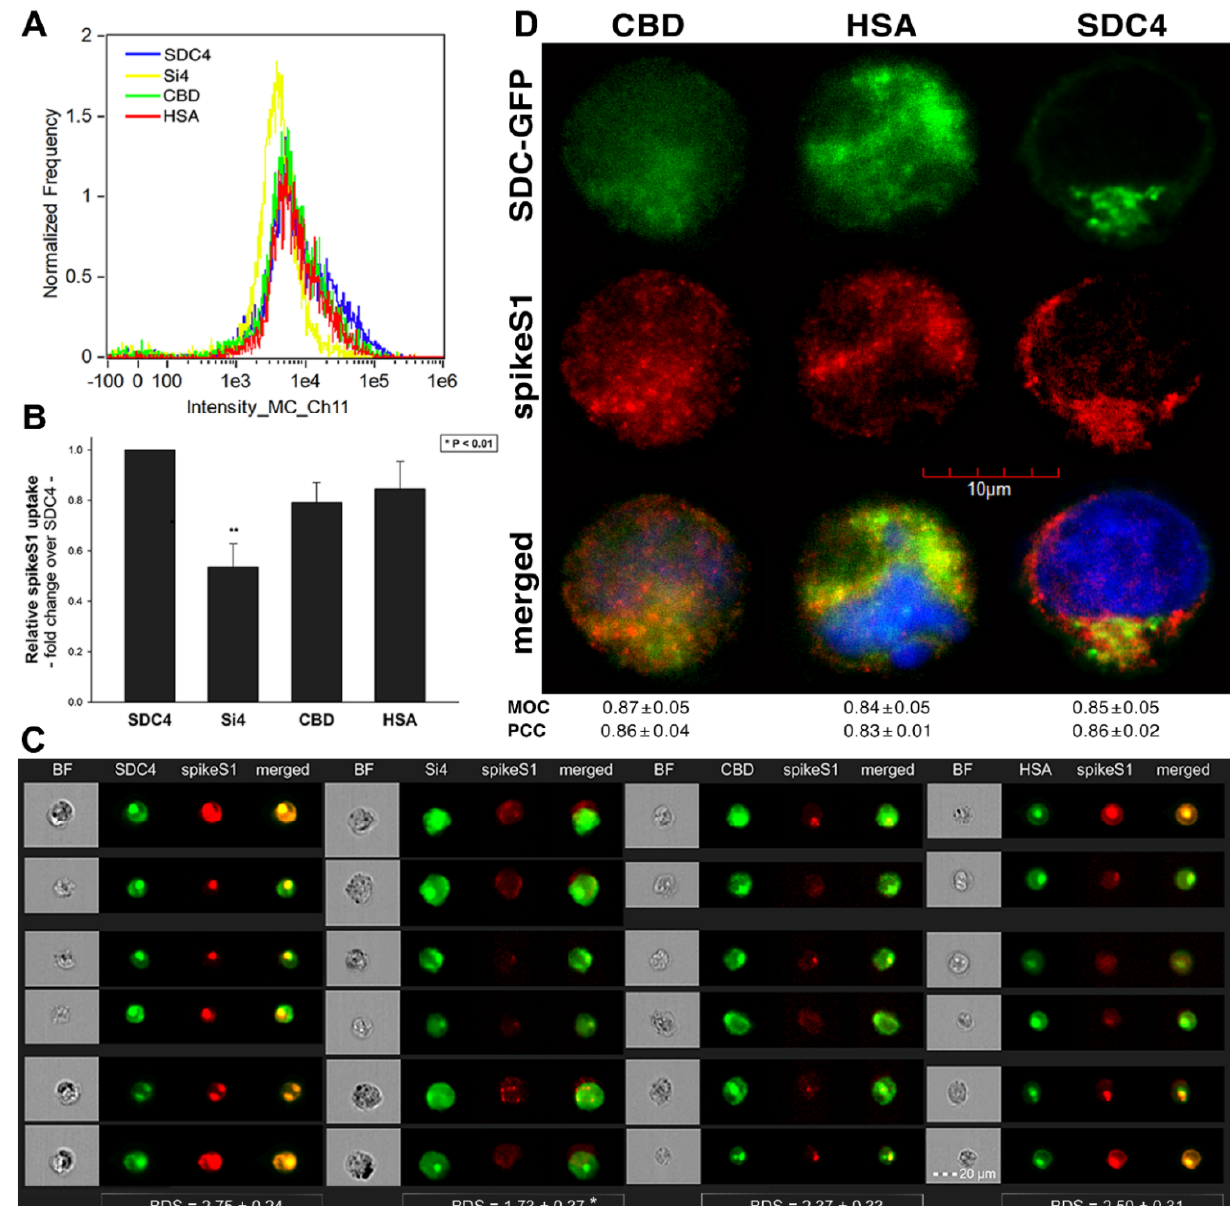
Figure 7. Contribution of the various parts of the SDC4 ectodomain to spikeS1 uptake. SDC4 transfectants and mutants were incubated with spikeS1 for 18 h at 37 °C. After incubation, the cells were washed, trypsinized, fixed, permeabilized and treated with AF 633-labeled antibodies specific for the His-tag of the recombinant spikeS1. Cellular uptake of spikeS1 was then analyzed with imaging flow cytometry and confocal microscopy. ( A ) A representative flow cytometry histogram showing the intracellular fluorescence of spikeS1-treated SDC4 transfectants and mutants. ( B ) Detected fluorescence intensities were normalized to spikeS1-treated WT SDC4 transfectants as standards. The bars represent the mean ± SEM of three independent experiments. Statistical significance vs. standards was assessed with ANOVA. ** p < 0.01. ( C ) Imaging flow cytometry visualization of colocalization between SDC4 mutants and spikeS1. Representative images of four independent experiments are shown. Scale bar = 20 μm. The indicated BDS represent the mean ± SEM of four independent experiments. Statistical significance vs. spikeS1-treated SDC4 transfectants was assessed with ANOVA. * p < 0.05. ( D ) Colocalization of spikeS1 and SDC4 mutants detected with confocal microscopy. Representative images of three independent experiments are shown. Scale bar = 10 μm. MOC ± SEM and PCC ± SEM fwas calculated by analyzing 12 images with an average of 12 cells in each image (from 3 separate samples). No statistically significant differences were detected between the groups.